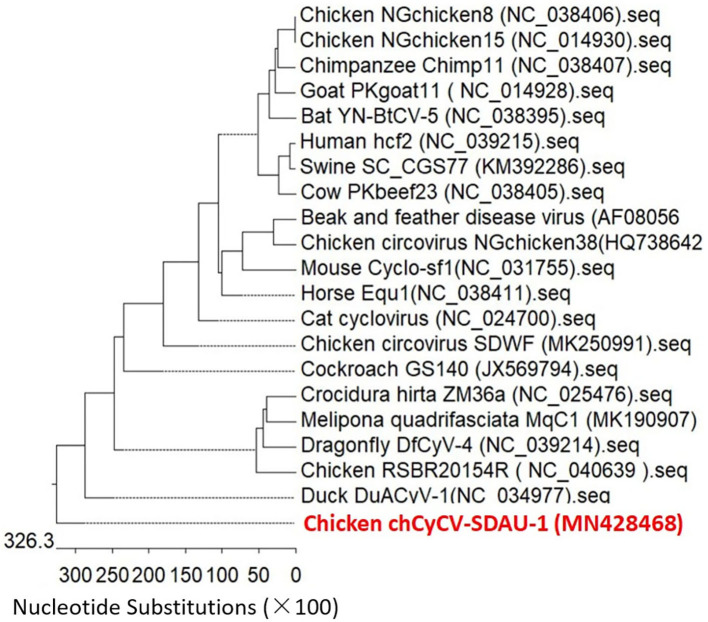
chCyCV-SDAU-1 gene structure. CyCV-SDAU-1 containing two major ORFs of the Rep and Cp proteins and two IRs.